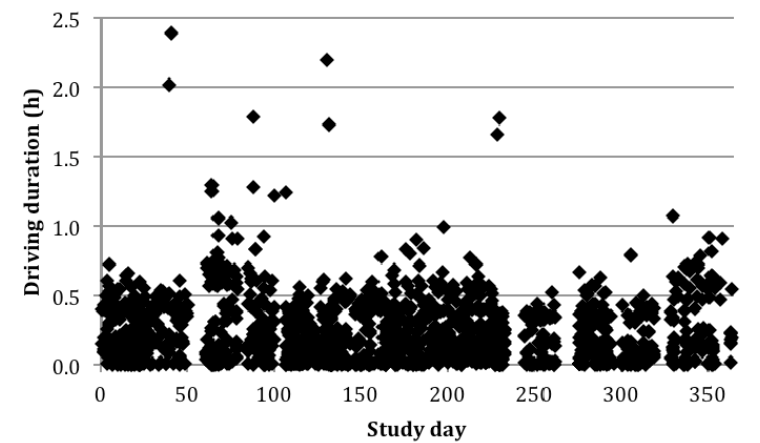
Figure A-1. Driving duration